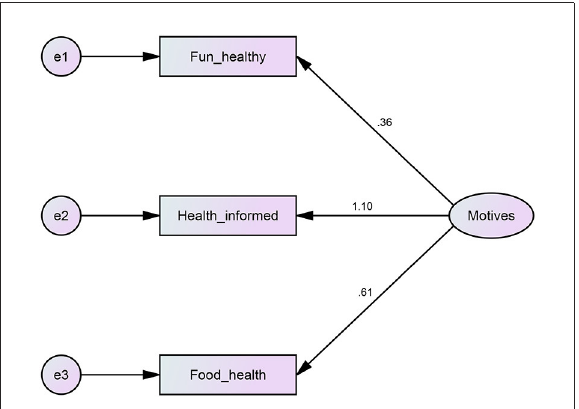
FIGURE3 Flow chart of the confirmatory analysis for the tested model (AMOS 22 Software, IBM, Chicago, USA) with regard to the validation of the